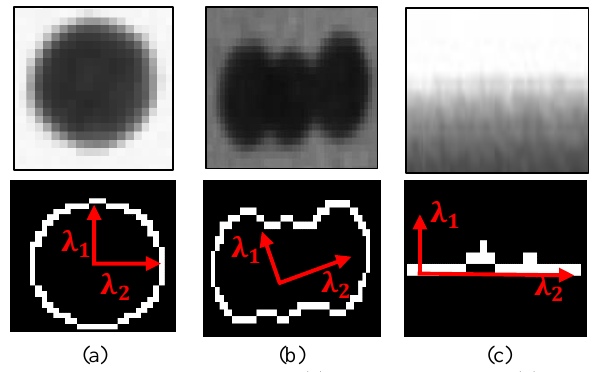
Figure 6. PCA of edge pixels, (a) circular-like shape, (b) oval- like shape and (c) linear-like shape